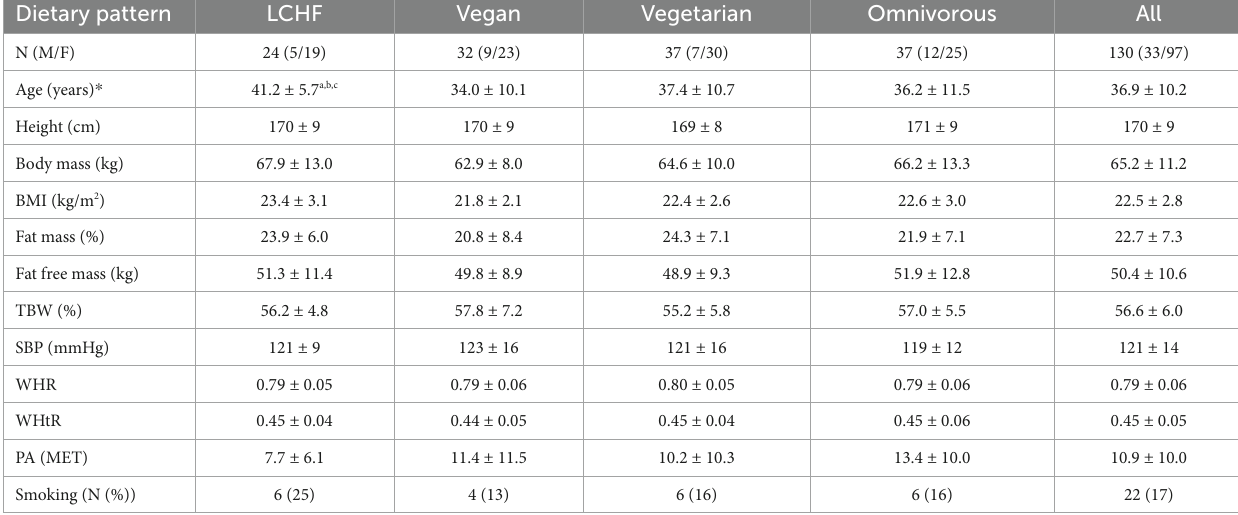
TABLE 1 Characteristics of study subject by dietary pattern. Dietary pattern LCHF Vegan Vegetarian